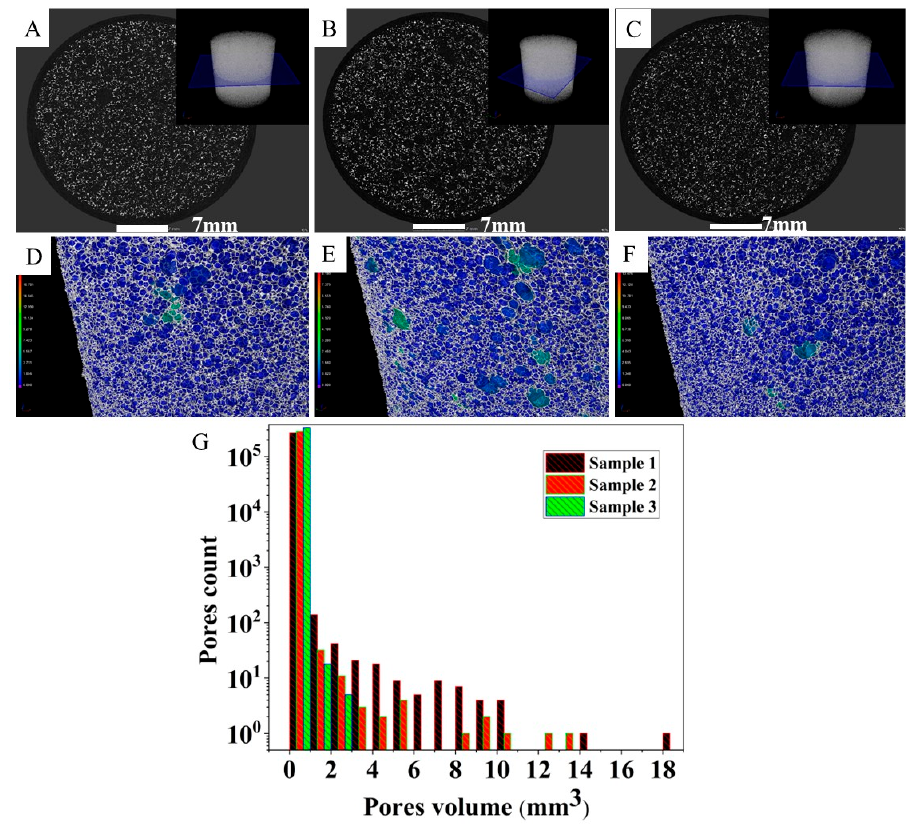
Figure 5. Micro-CT mapping plane and images of sample 1 ( A , D ), sample 2 ( B , E ), and sample 3 ( C , F ) along with the pore volume distribution ( G ).